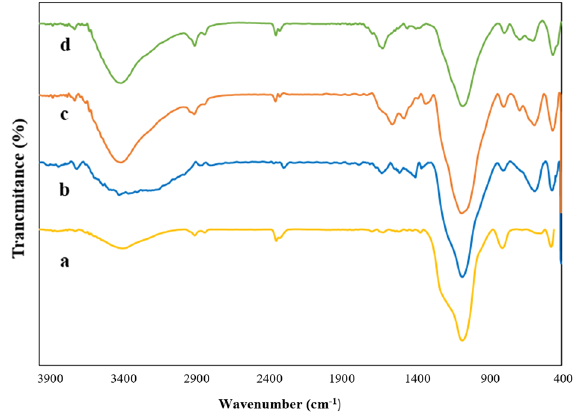
Figure 2. FT-IR of ( a ) SBA-15, ( b ) SBA-15/Fe 3 O 4 , ( c ) APTES@SBA-15/Fe 3 O 4 and ( d ) guanidinylated SBA-15/